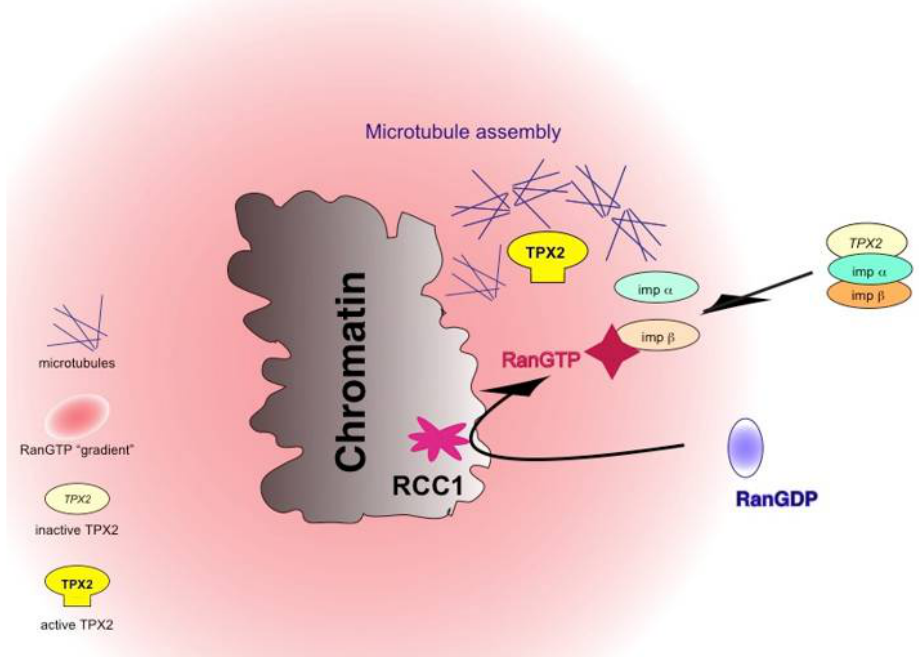
Figure 4. Paradigm of the mechanism of Ran in spindle formation. RanGTP activates numerous spindle assembly factors by release from nuclear import receptors (imp, importin, shown here) or, alternatively, association with nuclear export receptor CRM1 (not shown, see text). Please note that importin can be only importin β, or the importin β/importin7, or the importin α/β heterodimer. The production of RanGTP depends on the activity of the chromatin protein Rcc1, the G-nucleotide exchange factor of Ran.